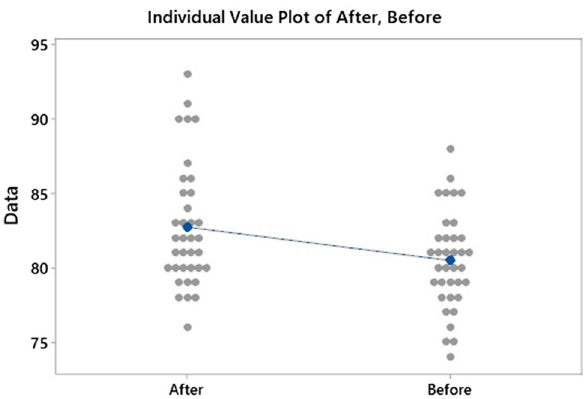
Fig. 13 Individual values before and after parameter